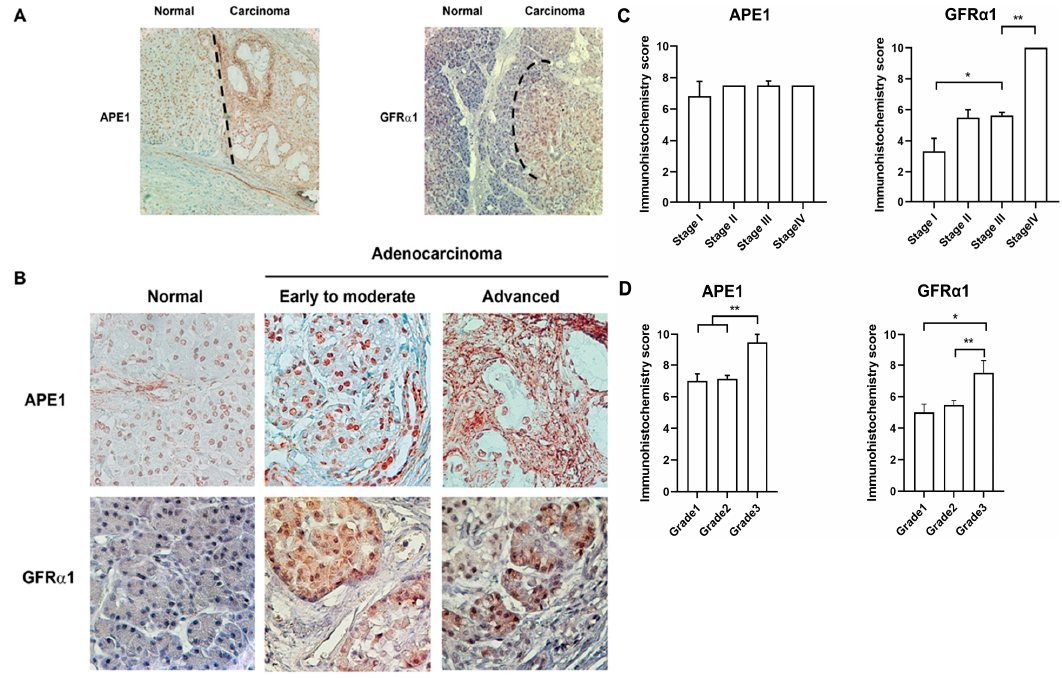
Figure 4. APE1 and GFR α 1 expression during pancreatic cancer progression. ( A ) Representative images of APE1 and GFR α 1 expression in a normal pancreatic ductal epithelium and pancreatic ductal adenocarcinoma by immunohistochemistry with anti-GFR α 1 and anti-APE1 antibodies. Brown staining indicates positive APE1 or GFR α 1 staining. Magnification, 10 × . ( B ) APE1 and GFR α 1 expression in normal pancreatic ductal epithelium, early to moderate and advanced pancreatic ductal adenocarcinoma by immunohistochemistry. ( C – D ) The level of APE1 and GFR α 1 dependent on TNM stages/grades was assessed by immunohistochemistry scoring. TNM stage system stands for classification of solid tumor using the size and the extension of the spread of primary tumor. (T, size or the direct extension of primary tumor; N, the degree of spread to regional lymph nodes; M, the presence of distant metastasis to other organ beyond regional lymph node). Grades indicate di ff erentiation status (grade 1, well di ff erentiation; grade 2, moderate di ff erentiation; grade 3, poor di ff erentiation). * Denotes p < 0.05. ** Denotes p < 0.01 by t -test and two-way ANOVA for equality of